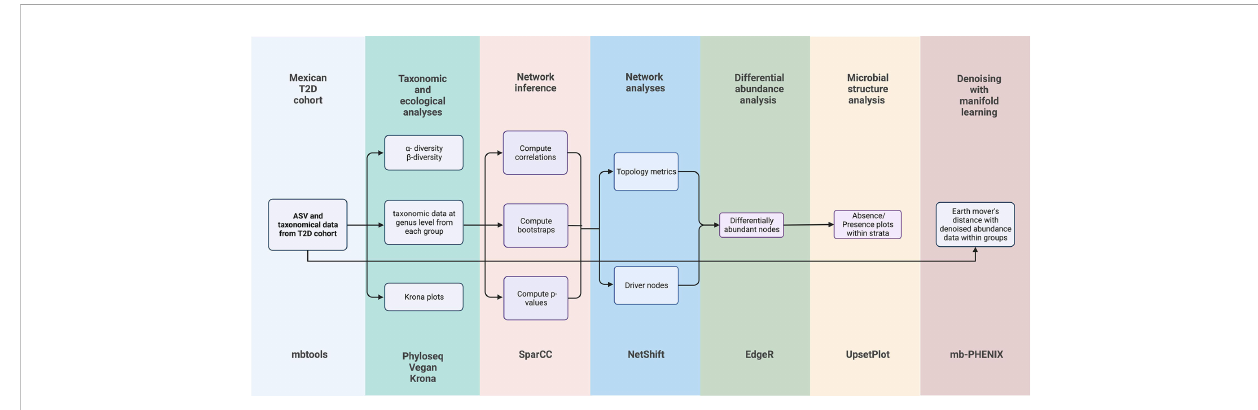
FIGURE 1 Experimental and Bioinformatics for taxonomic and ecological analyses, inference networks, network analyses, differential abundance analyses, microbial structure analyses, and supervised machine learning analysis. Bioinformatic tools are added at the bottom of the fi